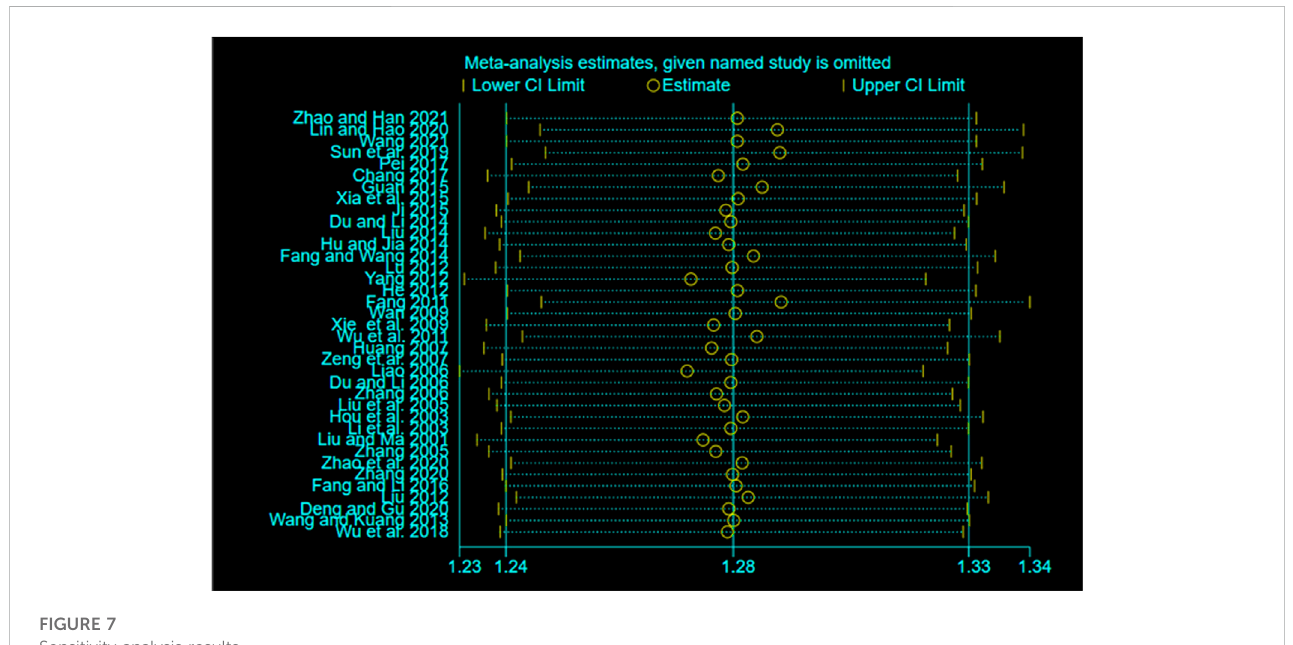
FIGURE 7 Sensitivity analysis